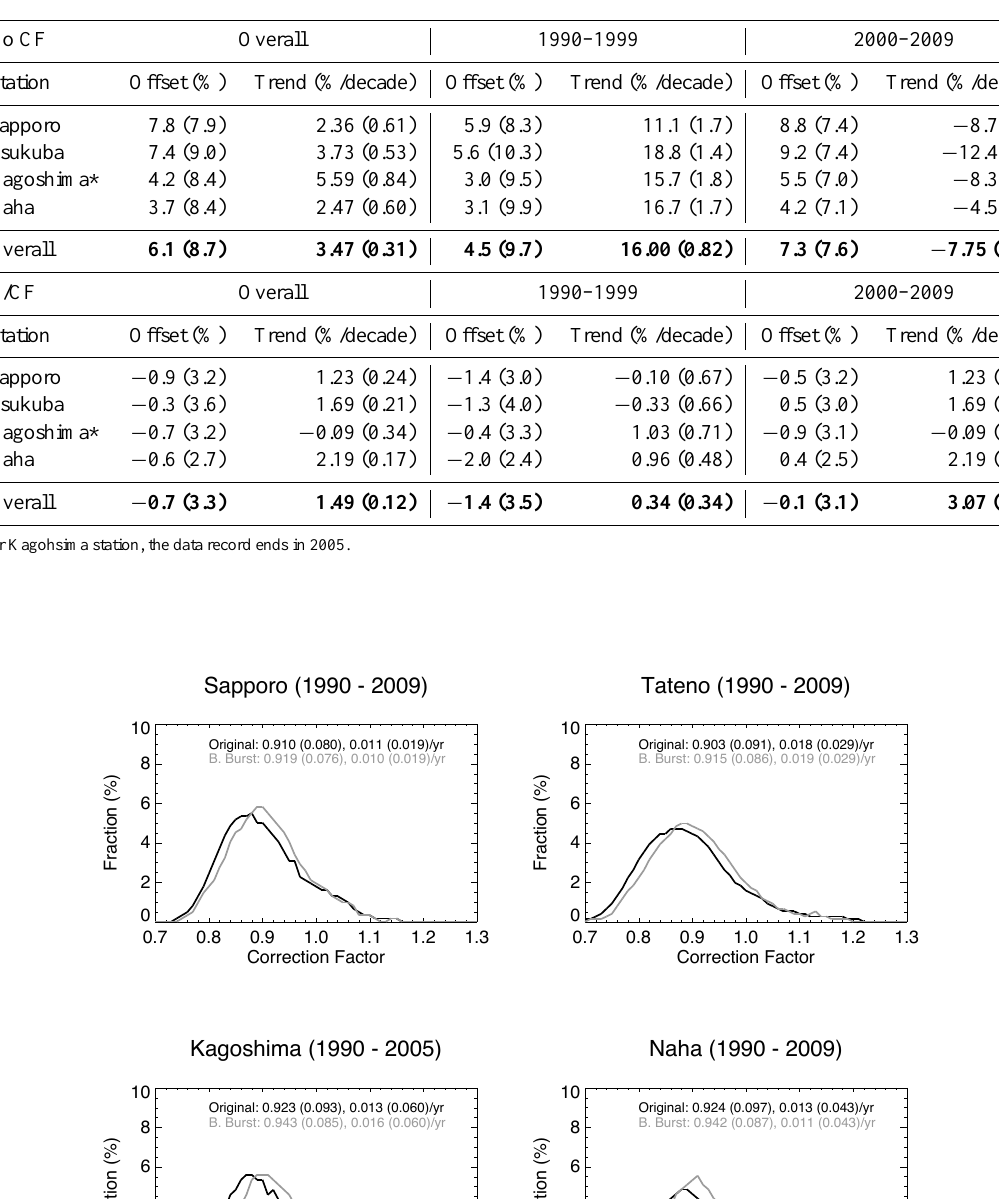
Table 3. Trends in the differences between sonde and satellite ozone columns, and the mean offsets in those column ozone differences (Japanese ozonesonde columns minus TOMS/OMI columns) for the period 1990–2009 (“Overall”) as computed with and without the CF applied. The calculations are based only on those sondes that reach a minimum altitude of 32km (10.5hPa) before bursting. The numbers in parenthesis in this and the following tables represent one standard deviations.